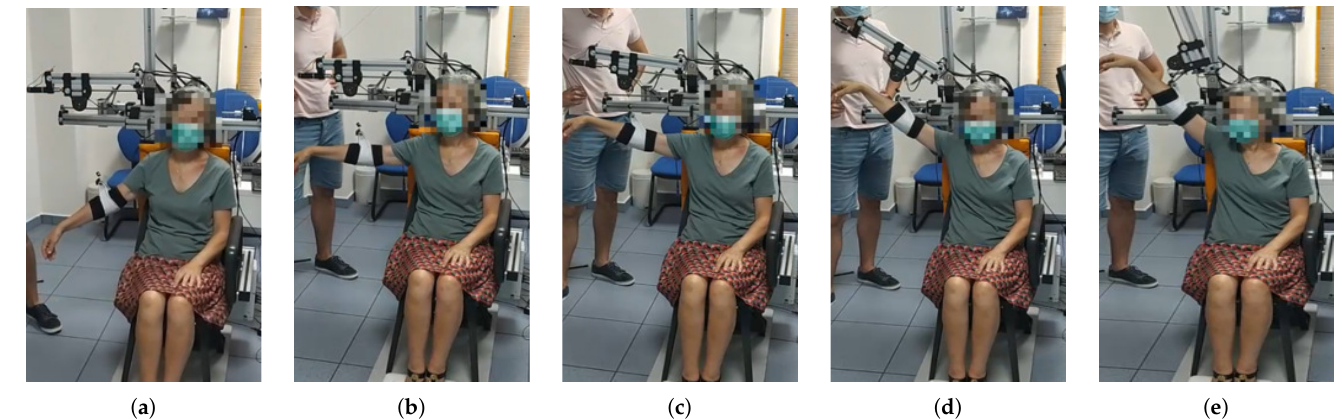
Figure 4. From ( a – e ) a series of frames corresponding to an abduction movement ( θ = 90 ◦ ) increasing the angle φ are shown. Note that the exoskeleton end effector is not moved until the subject ´ s arm is at 90 degrees. From then on, motors m2 and m3 move synchronously in order to properly move motor m1 in the workspace while the cable length is being controlled.